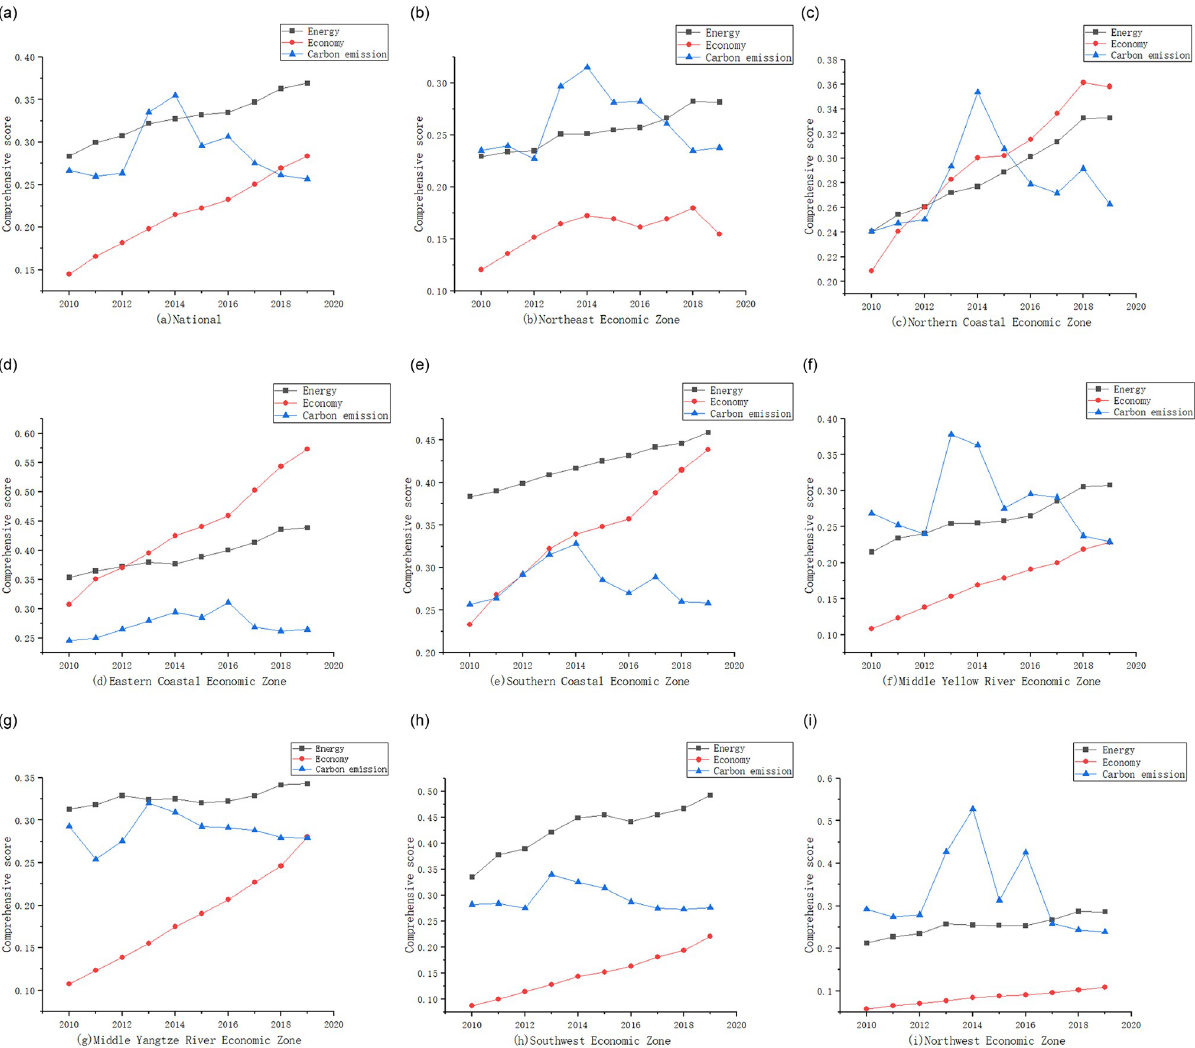
Fig 2. Comprehensive level of energy-economy-carbon emission subsystems in China and the eight economic